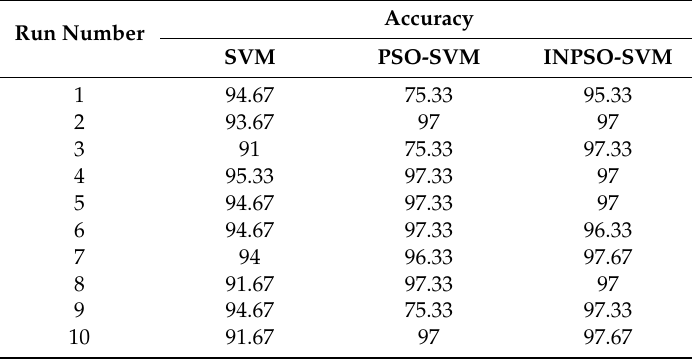
Table 5. The accuracy of di ff erent fault diagnosis